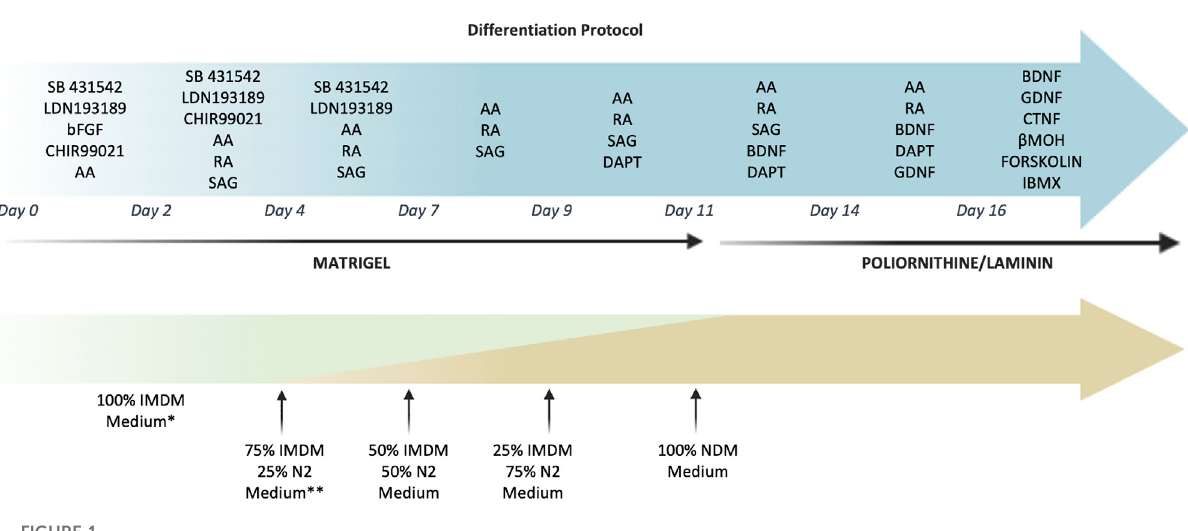
FIGURE 1 Timeline and culture conditions for theMN differentiation of hAFSCs. The picture reported in detail thesmall molecules used to induce the MN differentiation. Cells were grown on Matrigel until day 11 and then were detached and replated on polyornitine/laminin plates. During